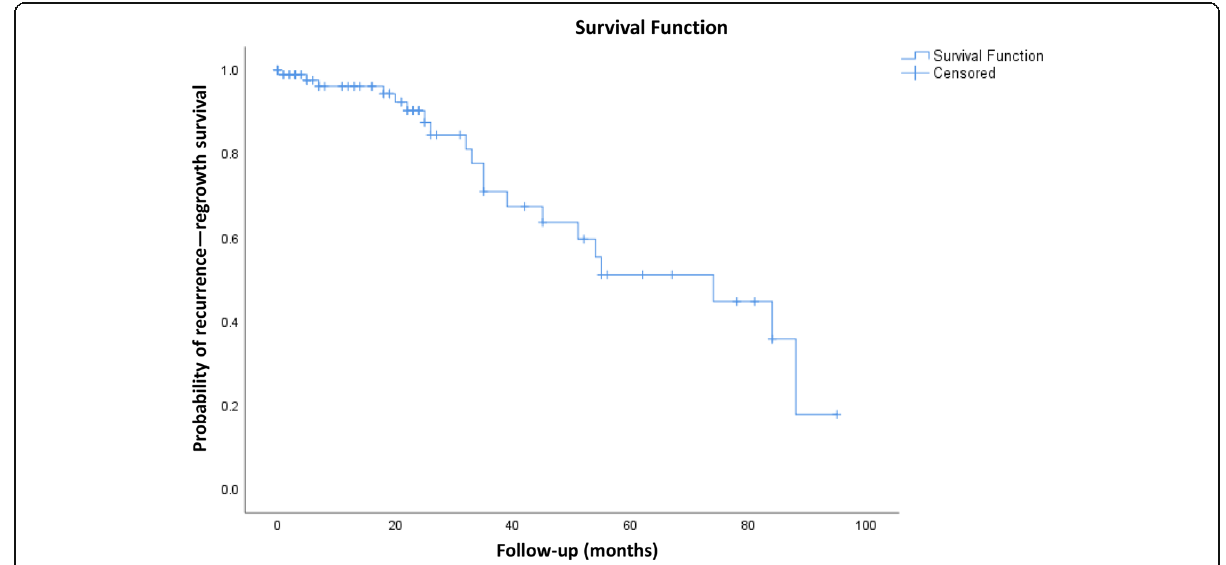
Fig. 1 Kaplan-Meier curve demonstrating recurrence-regrowth free survival rate in meningiomas